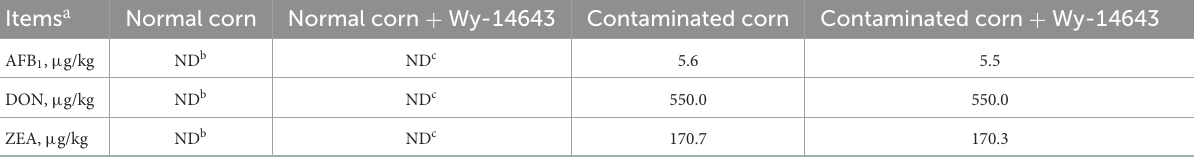
TABLE 3 Mycotoxin content of the experimental